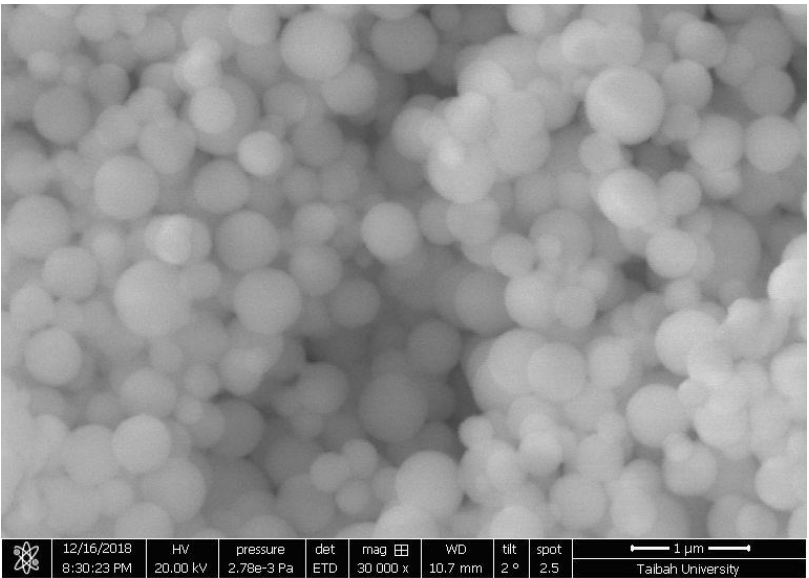
Figure 5. Scanning electron microscopy (SEM) images of pure adsorbent 1 before adsorption.